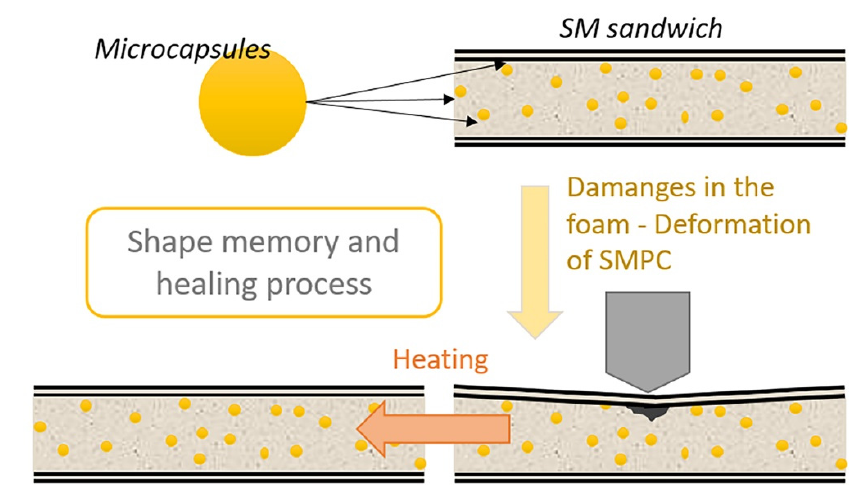
Figure 5. The shape memory and healing process schematization.